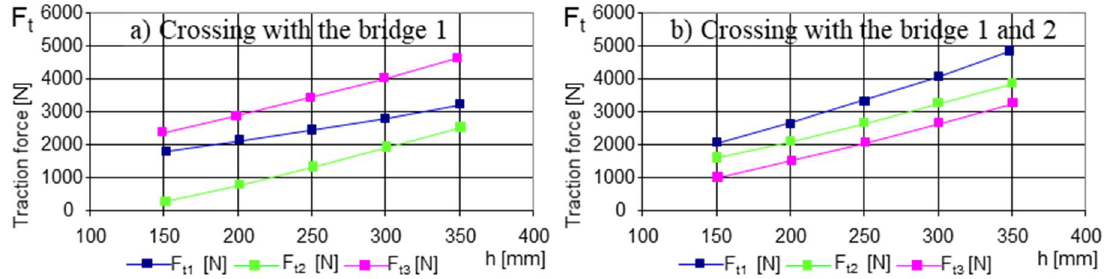
Figure 13. The variation in the F t [ N ] necessary for crossing an obstacle as a function of its height. The explanations presented in Figure 12 also apply here: ( a ) crossing with bridge 1; ( b ) crossing with bridges 1 and 2.